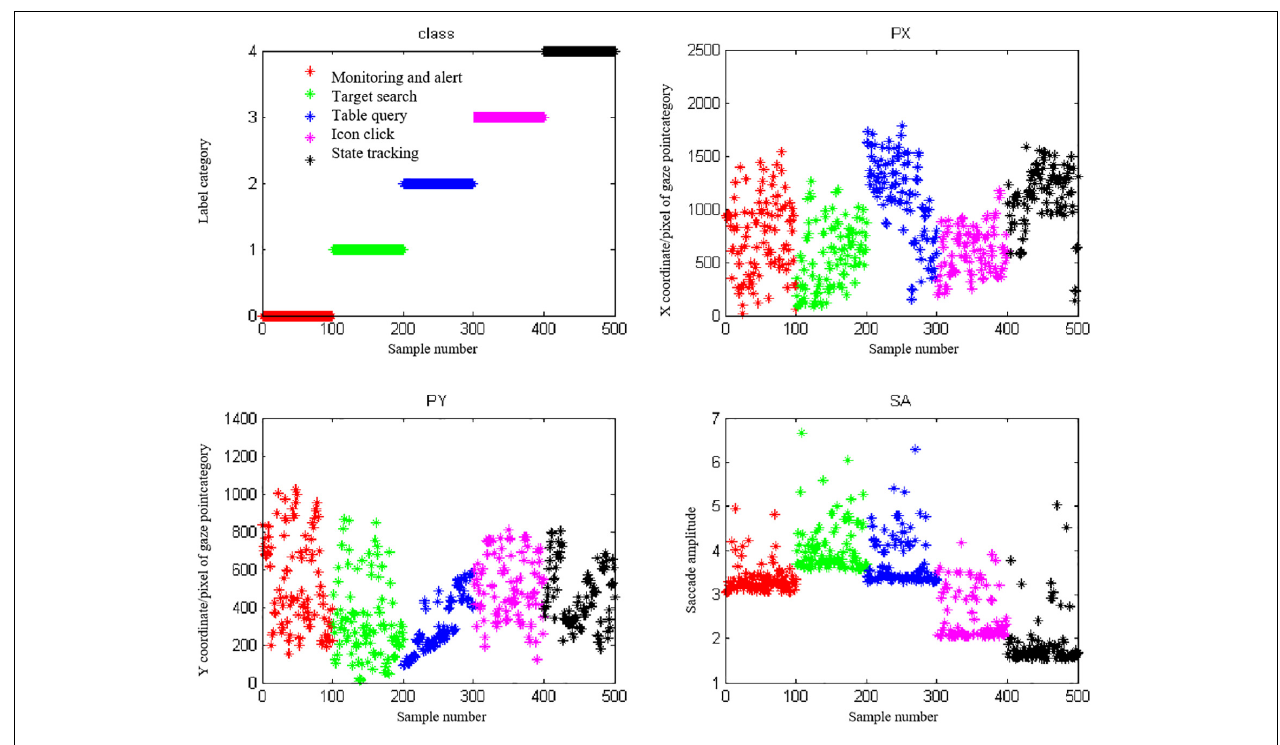
FIGURE 9 | A total of 500 Distribution of typical data.